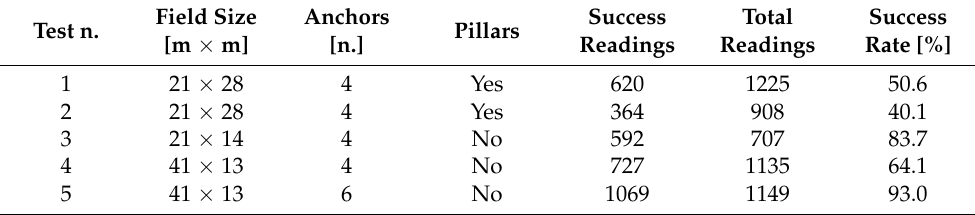
Table 9. Summary of results from tests 1–5 in terms of success reading rate. Field Size Anchors Success Test n. Pillars [m × m] [n.] Readings